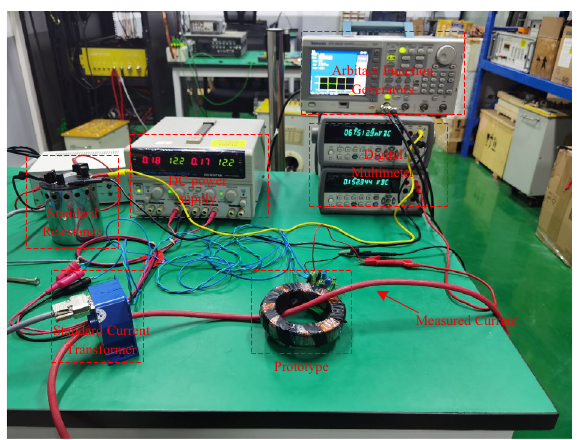
Figure 8. Experimental platform.